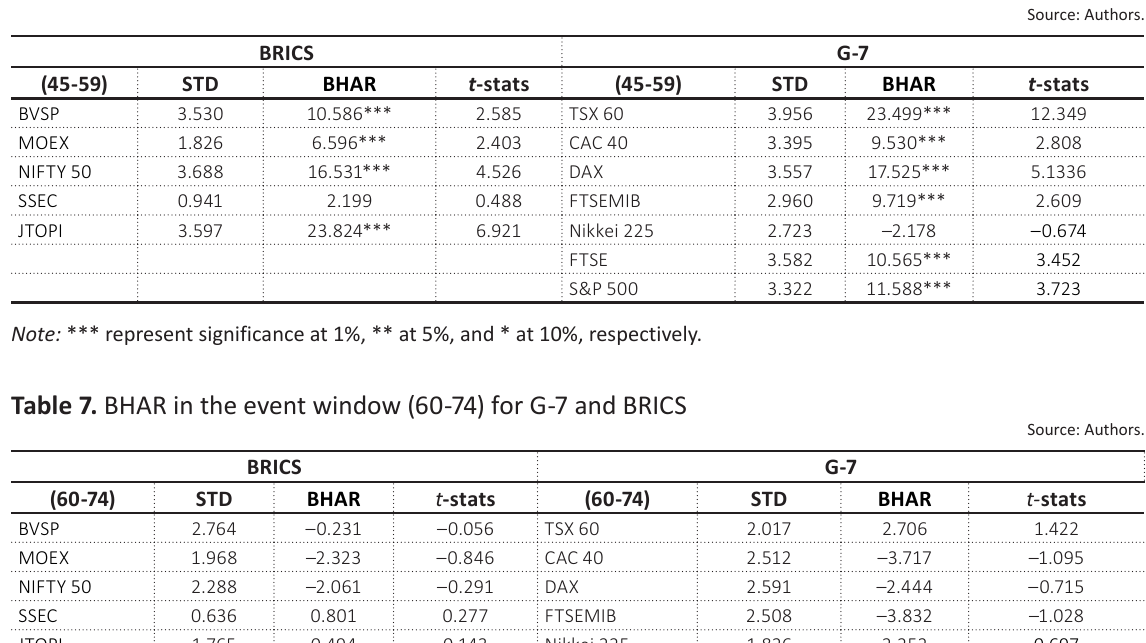
Table 6. BHAR in the event window (45-59) for G-7 and BRICS